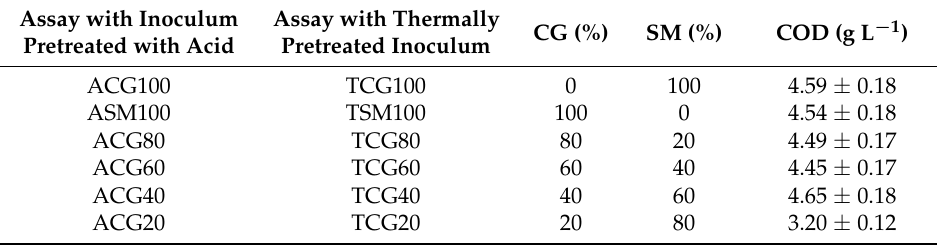
Table 6. Experimental essays of hydrogen yield from CG and SM with two different inocula. Assay with Inoculum Assay with Thermally CG (%) Pretreated with Acid Pretreated Inoculum ACG100 TCG100